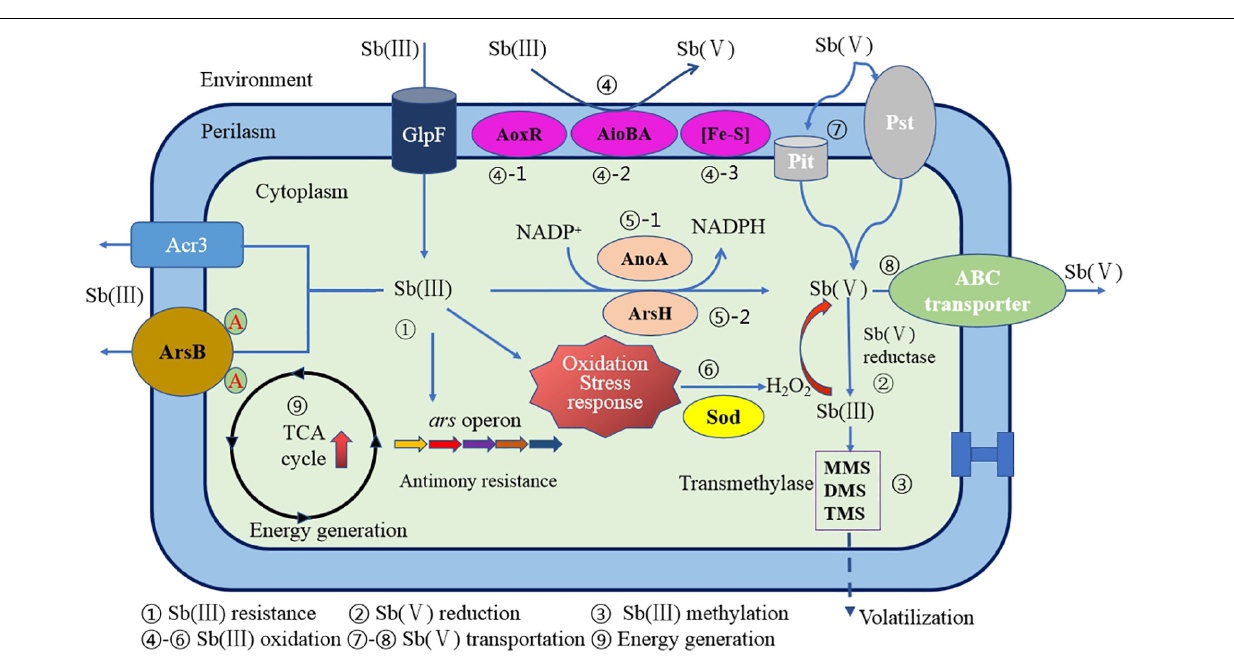
FIGURE 6 | Overview of mechanisms of bacterial antimonite oxidation (Liu et al., 2015; Wang et al., 2016; Li, 2017). (A) A hypothetical model of IscR’s regulation of bacterial Sb(III) oxidation in A. tumefaciens GW4. (i) Sb(III) induced the production of H 2 O 2 via the bacterial oxidative stress response. (ii) H 2 O 2 was partially consumed by catalase KatA . (iii) Sb(III) induced the expression of (Fe–S) assembly transcription factor IscR, which could positively contribute to GSH formation. (iv) Then, H 2 O 2 was partially consumed by GSH. (v) Subsequently, H 2 O 2 oxidized Sb(III) to Sb(V). (B) The proposed model for Sb(III) bacterial oxidation in P. stutzeri TS44. (i) the addition of Sb(III) would trigger the ROS-protective system by inducing the transcription of sodB , sodC , and katE , with SodB and SodC catalyzing the conversion of ROS to H 2 O 2 , while KatE is responsible for the degradation of excessive H 2 O 2 ; (ii) the increased cellular H 2 O 2 content enhanced the Sb(III) oxidation rate; (iii) the addition of Sb(III) played a selection role on the characterization of gshA insertion; (iv) the accumulated H 2 O 2 is partially consumed by the upregulated catalase KatE .